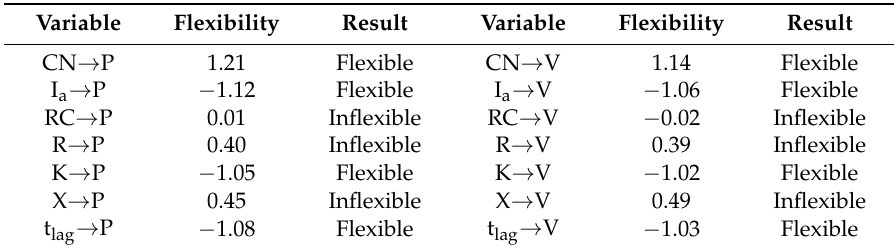
Table 3. Flexibility coefficients of the model.